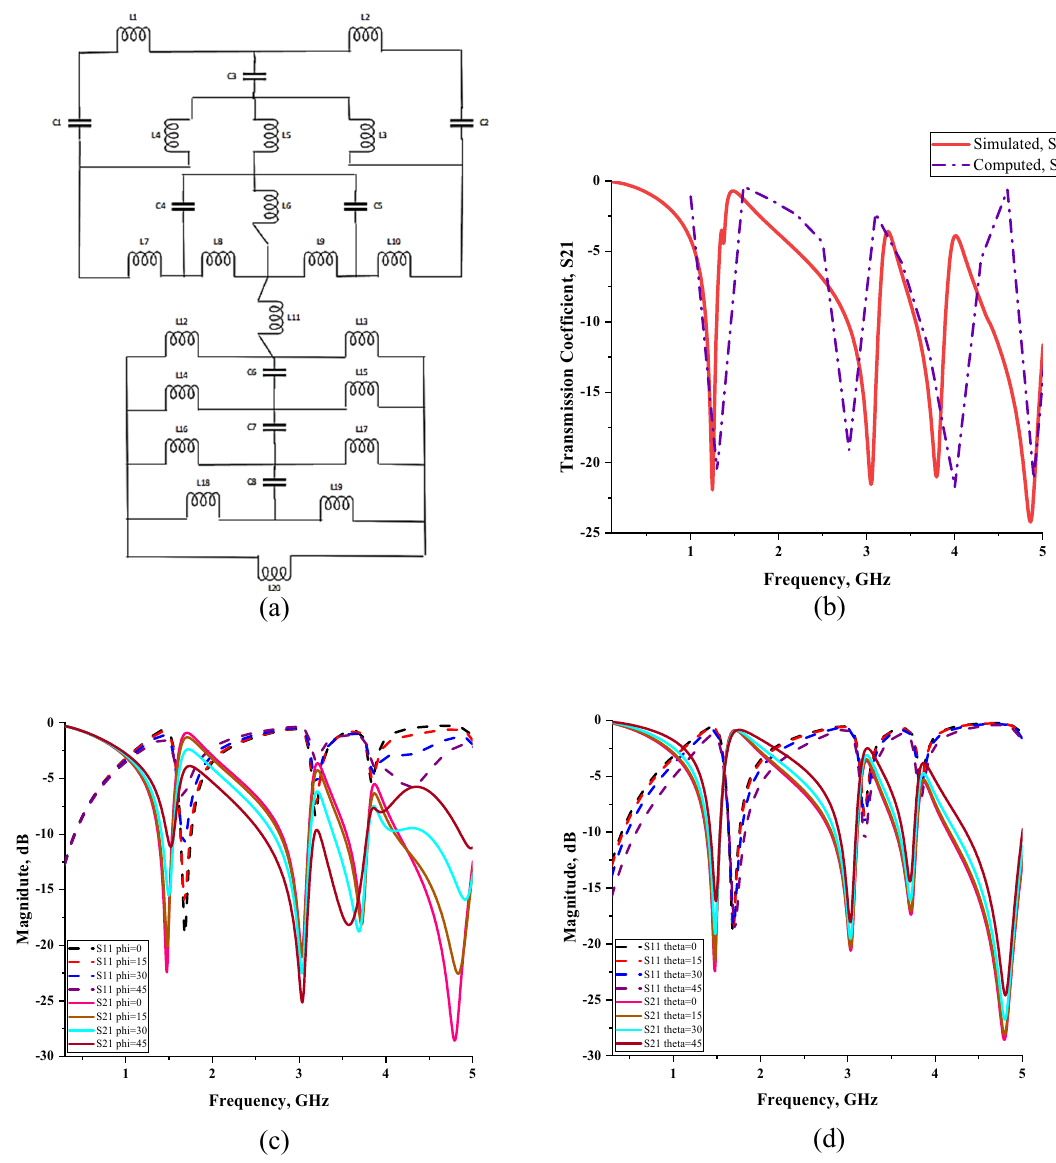
Figure 4. SM design: ( a ) equivalent circuit model, ( b ) comparison of simulated and computed S21 results, ( c ) polarization, ( d ) incident